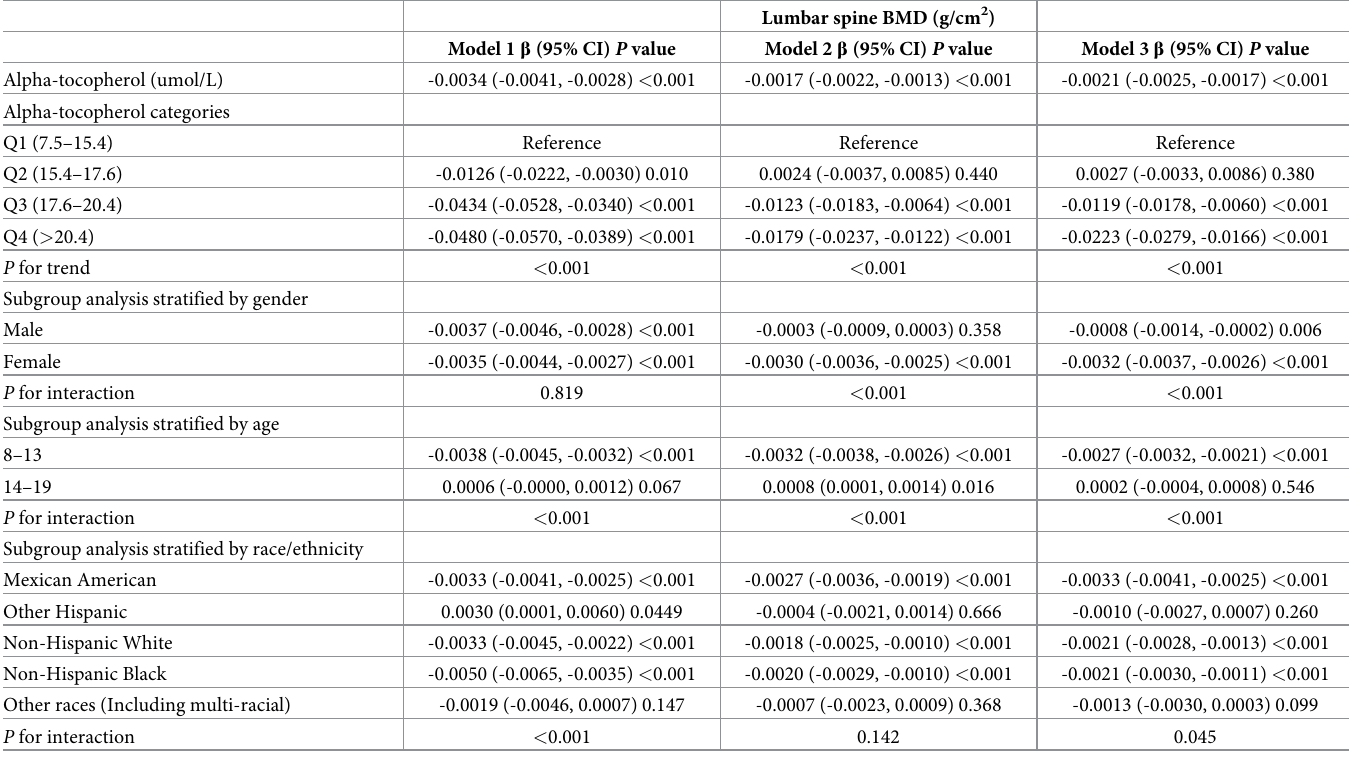
Table 2. The association between serum alpha-tocopherol and lumbar spine